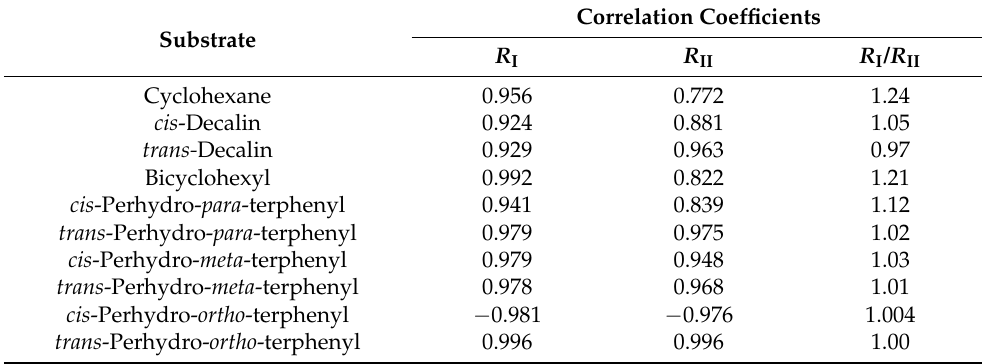
Table 5. Empirical values of correlation